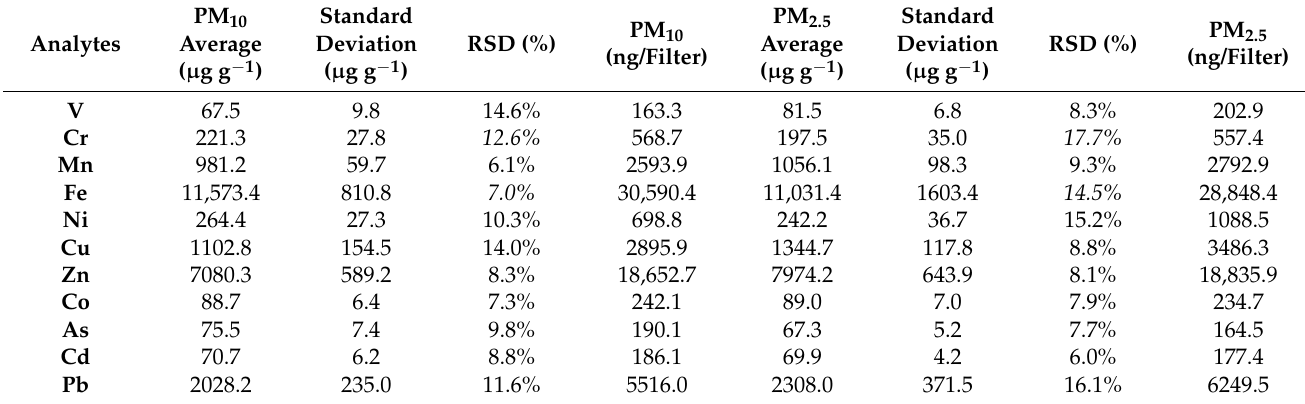
Table 3. All average, standard deviation and RSD values for particulate matter PM 10 and PM 2.5 for all metals.